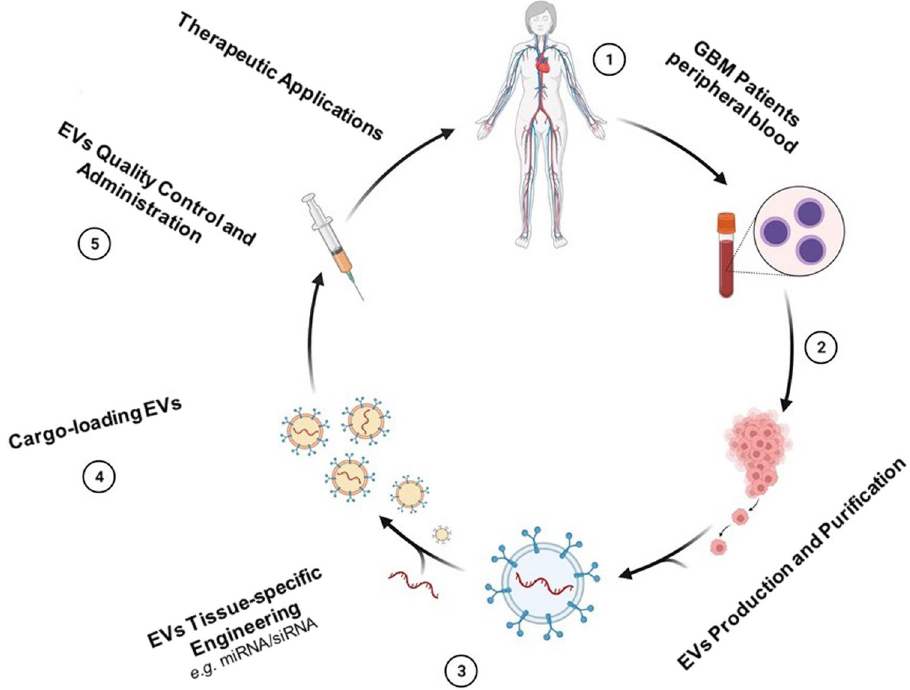
Fig. 2 Self-derived GBM EVs for therapeutic applica- tions. EVs are extracted from patient blood. EVs could